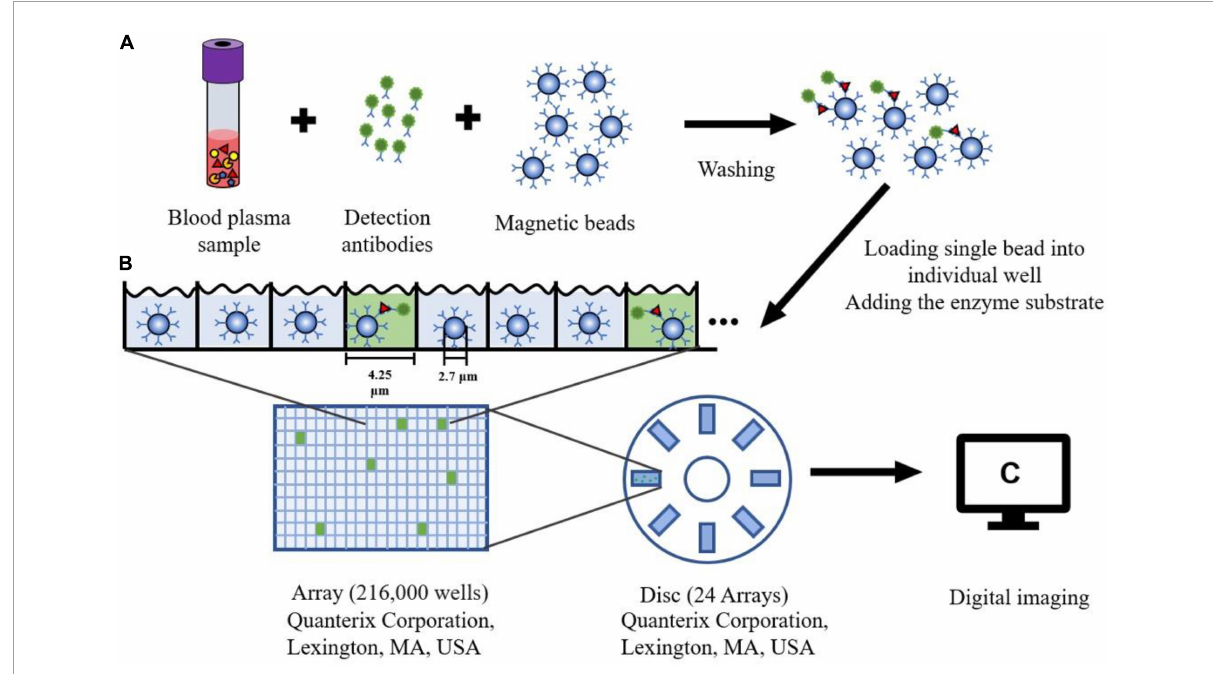
FIGURE3 The schematic diagram of Single Molecule Array. (A) Blood plasma sample is mixed with the magnetic microbeads (2.7 µ m) with capture antibodies and detection antibodies. After washing the beads three times, the protein can be captured specifically bound by the antibody. (B) Each Single magnetic bead is loaded into one well (4.25 µ m diameter, 3.25 µ m depth) of the array (216,000 wells). The substrate for the enzyme is added to the well sealing with oil. (C) After fluorescence detection of each well, a single molecule signal image can be obtained on this